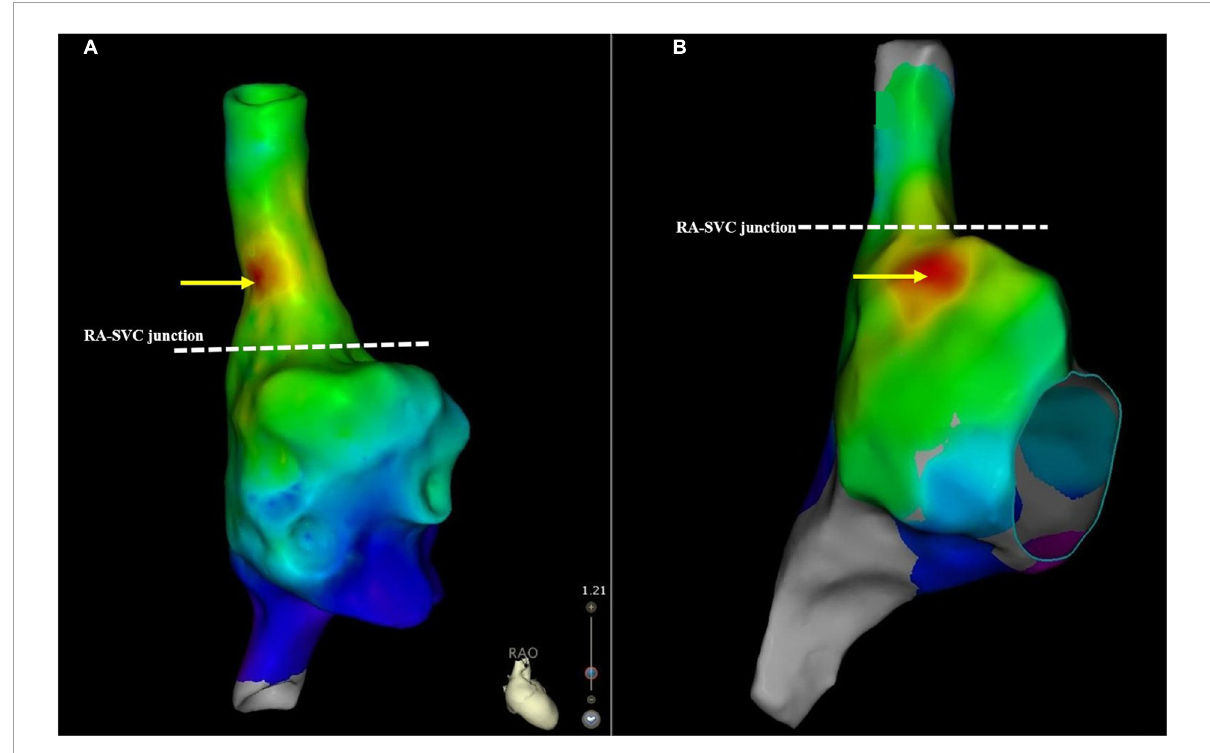
FIGURE4 A schematic illustration demonstrating the SAN location. (A) This case demonstrates the SAN located above the RA-SVC junction. (B) The SAN was below the RA-SVC junction. The yellow arrow indicates the location of the SAN. The white dotted line indicates the RA-SVC junction. RA, right atrium; SAN, sinus node; SVC, superior vena